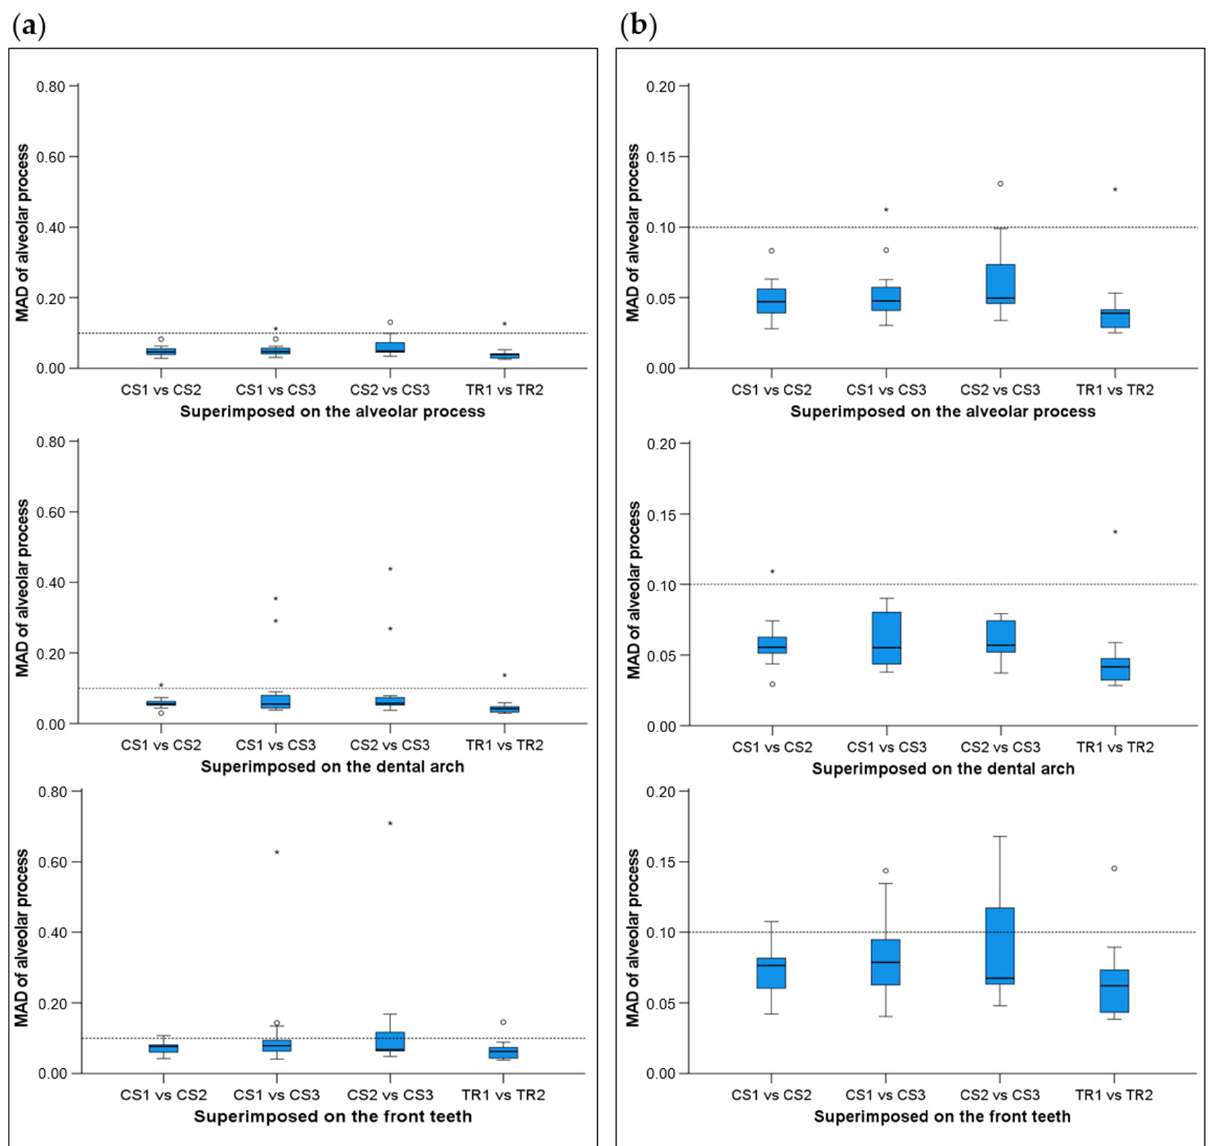
Figure 2. Box plots showing the precision (millimeters) assessment measured through the MAD of the alveolar process between repeated scans with the two different scanners (CS3600 and TRIOS3) when the alveolar process, the whole dental arch, or the front teeth were used as superimposition reference areas. ( a ) Boxplots showing all data. ( b ) Boxplots with magnification, not showing outliers. The upper limit of the black line represents the maximum value, the lower limit represents the minimum value, the box represents the interquartile range, and the horizontal line represents the median value. Outliers are shown as circles or stars in more extreme cases. The dashed horizontal lines indicate 0.1 mm MAD between the compared models. CS1, CS2, and CS3: CS3600 repeated scans. TR1 and TR2: TRIOS3 repeated scans. MAD: Mean Absolute